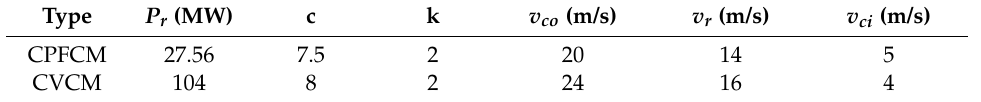
Figure 6. Layout of IEEE 30-bus system incorporating constant power factor control mode (CPFCM) and constant voltage control mode (CVCM) wind farms. Table 1. Wind farm rated power and wind speed